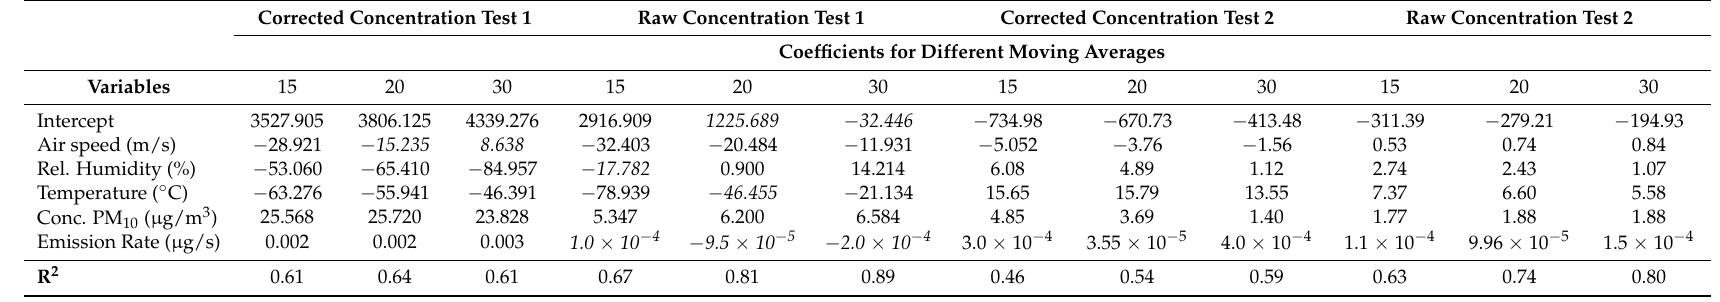
Table 5. Models generated from data collected with the TSI DRX and the collocated module using corrected concentrations and field data for Tests 1 and 2.